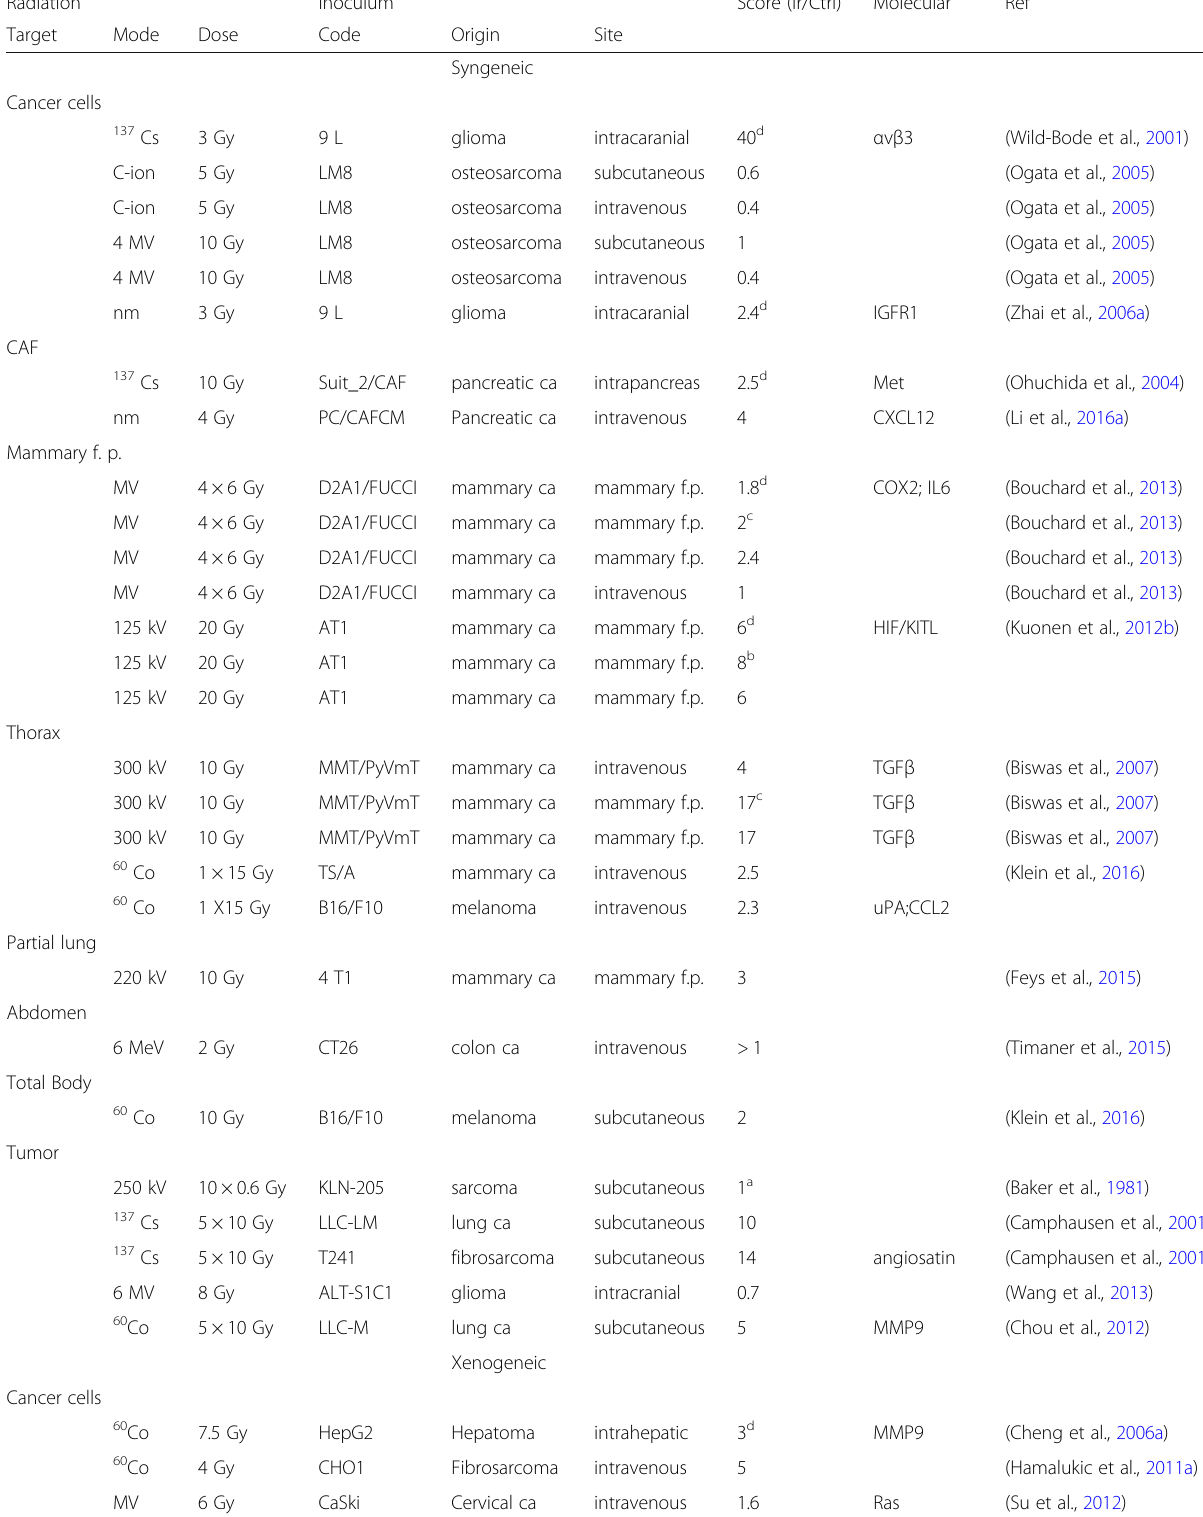
Table 3 Effect of radiation on local invasion or metastasis of rodent and human cancer cell lines as tested in syngeneic and in xenogeneic mice respectively Radiation Inoculum Score